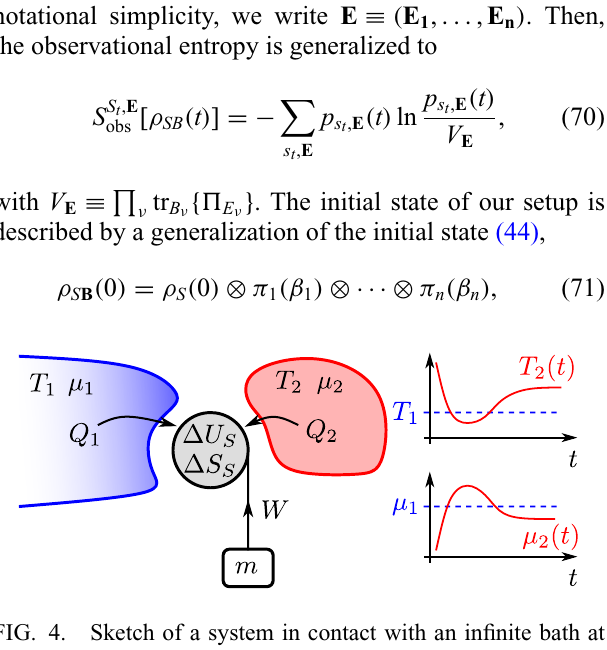
FIG. 4. Sketch of a system in contact with an infinite bath at temperature T 1 and chemical potential μ 1 , a finite bath at T 2 and μ 2 and a work reservoir (sketched by a weight m ). The system experiences a change in internal energy (cid:2) U S and system entropy (cid:2) S S due to heat flows Q 1 and Q 2 from the bath and the mechan- ical work W supplied to it. Since the second bath is finite, its temperature and chemical potential change with time t whereas T 1 and μ 1 remain unchanged (sketched on the